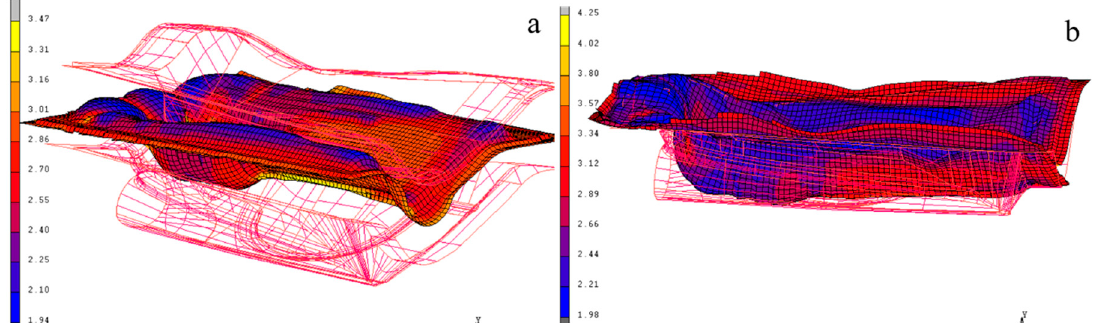
Figure 12. Thickness distribution of the drawing during the final forming process: ( a ) beginning; ( b ) end. (4)